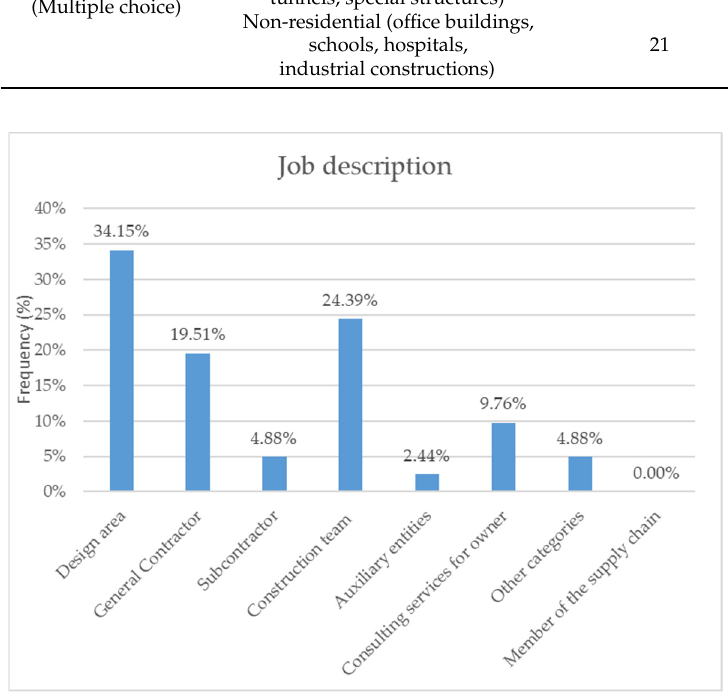
Figure 2. Job profile of the respondents.